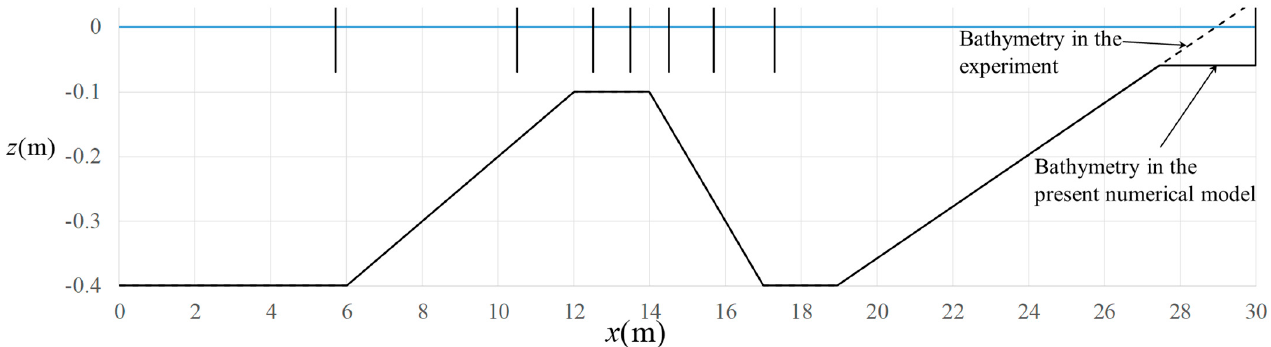
Figure 7. Layout of the experiment in [40] and the bathymetry of the present numerical model. Time series of the free surface elevation observed at 7 wave gauges are used